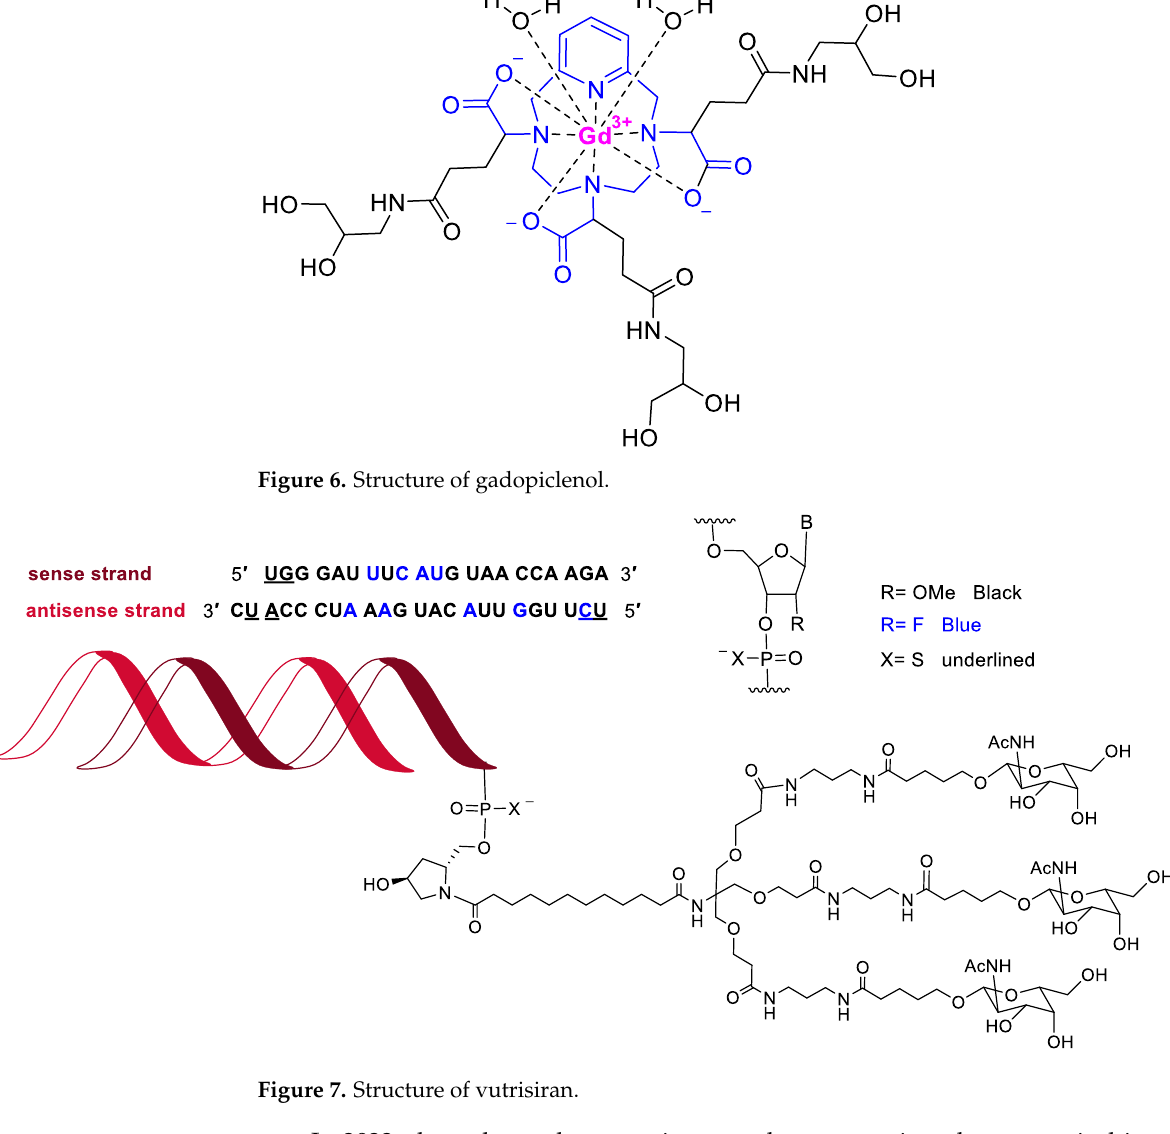
Figure 5. Structure of 177Lu vipivotide tetraxetan.